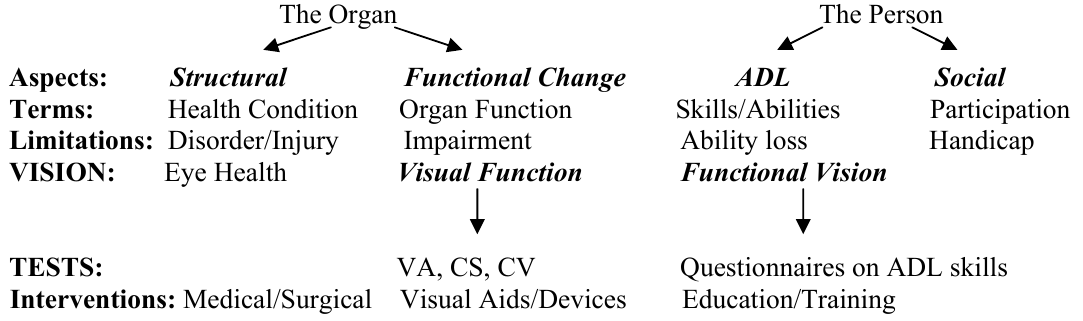
Figure 1. The four main aspects of vision loss classified into terms, limitations, application to vision, performance tests and interventions. ADL: Activities of Daily Living; VA: visual acuity; CS: contrast sensitivity; CV: colour vision. The table has been adapted from the WHO, International Classification of Visual Standards (2002